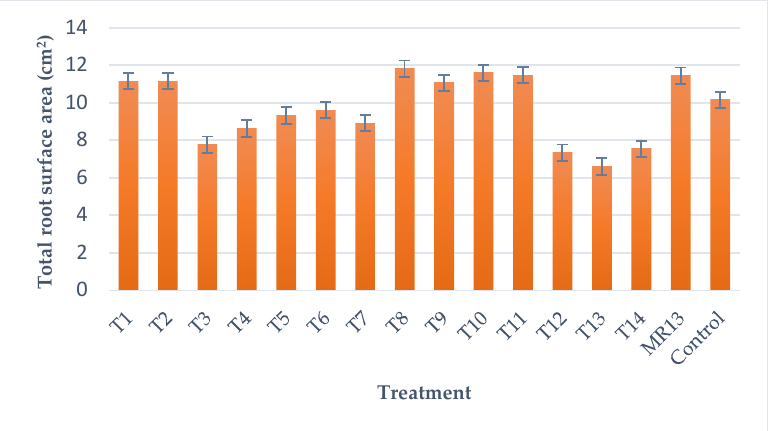
Figure 3. Total root surface area of chilli seedlings treated with endophytic bacteria and moringa leaf extract using various extraction methods. The values are an average of five independent meas- urements.